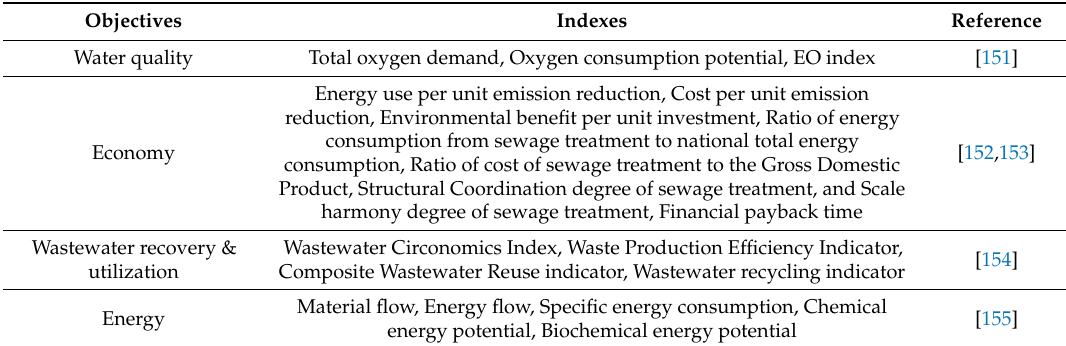
Table 7. Evaluation indexes adopted by di ff erent